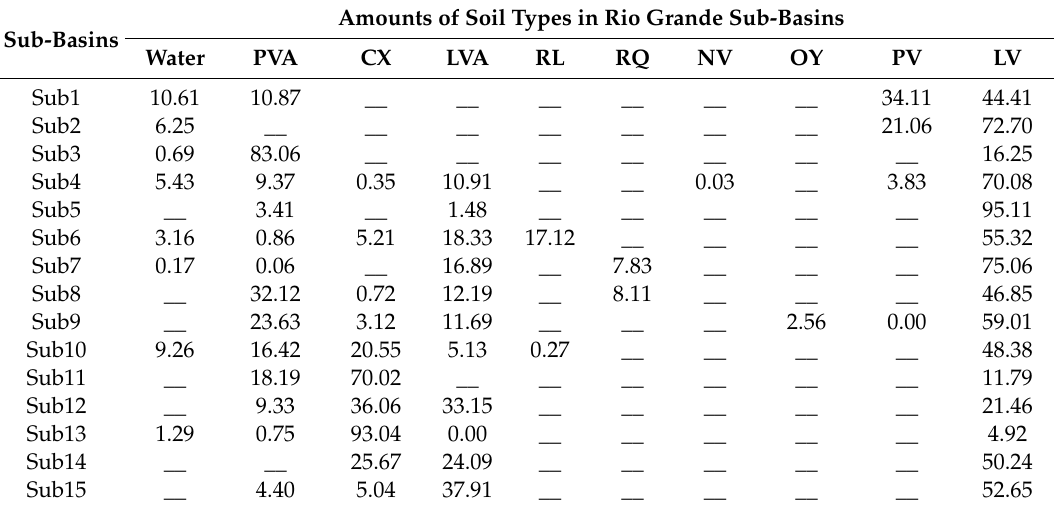
Figure 4. Soil capability of Rio Grande sub-basins. Table 5. Amounts (%) of soil types in Rio Grande sub-basins.